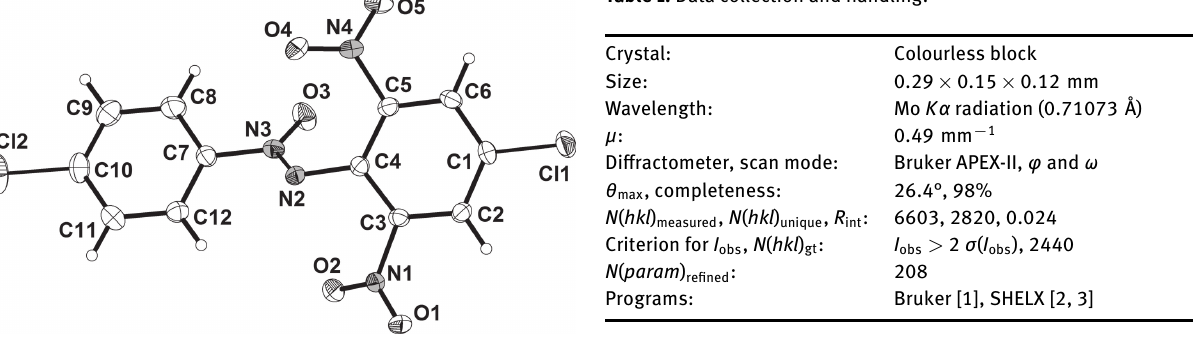
Table 1: Data collection and handling.